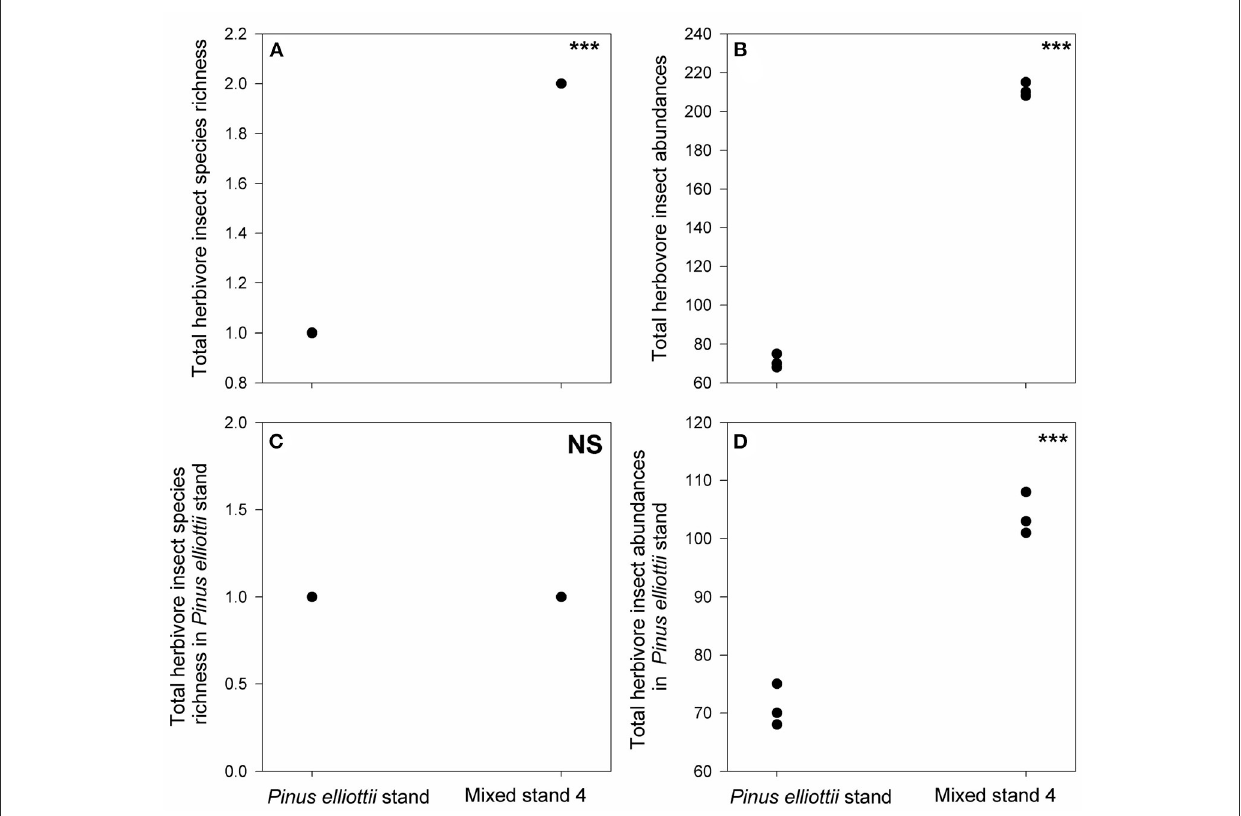
FIGURE6 Differences in total herbivore insect species richness (A) , total herbivore insect abundance (B) , total species richness of herbivore insects in Pinus elliottii stand (C) and their abundance (D) between mixed stand 4 and Pinus elliottii stand. *** indicates p < 0.05 and NS (non-significant) indicates p > 0.05, results from our generalized linear mixed effect model with Poisson